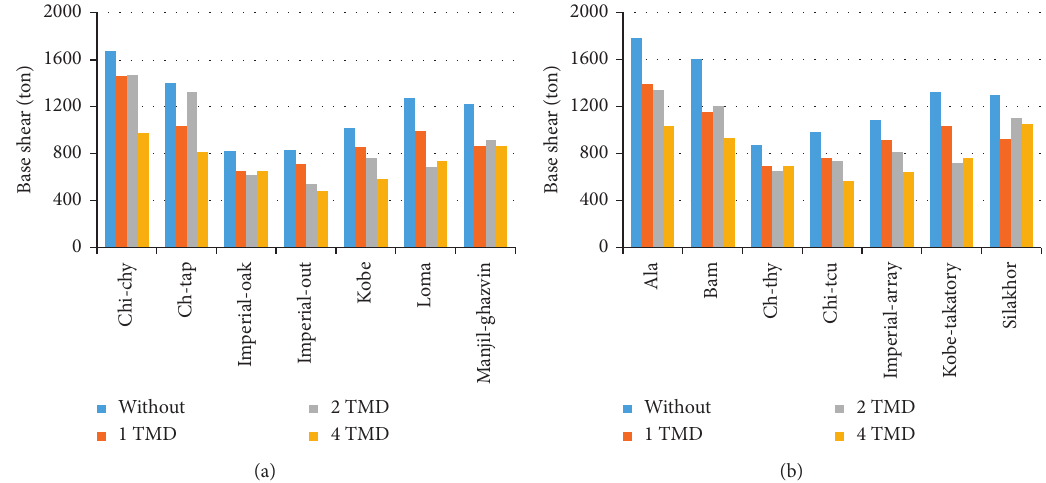
Figure 11: Maximum roof acceleration under the near-field (right) and far-field (left) earthquakes in the regular 10-story model.